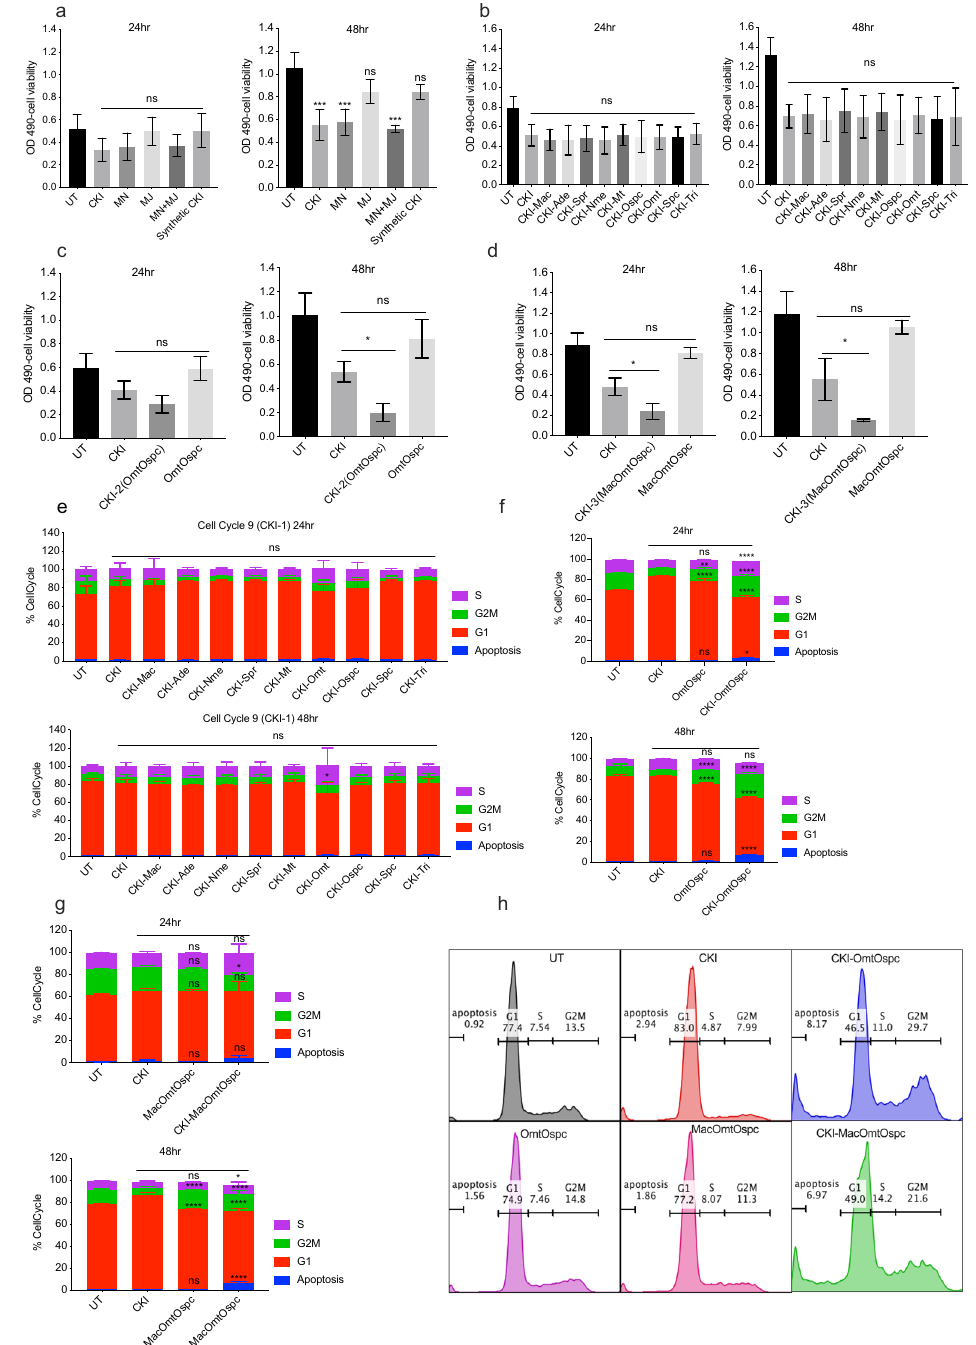
Figure 2. XTT cell viability assay and cell-cycle assay of subtractive fractions at 24- and 48-hour timepoint treatments in MDA-MB-231 cells treated with 2 mg/ml of CKI and 2 mg/ml equivalent concentrations of all other treating agents. ( a ) Suppression of cell viability from the following fractions: UT (untreated), MJ, MN, MJ + MN (combination of MJ and MN) and Syn_CKI (synthetic CKI generated using nine major compounds). ( b ) Effect of 9 (CKI-1) subtractive fractions compared to CKI. ( c ) Effect of CKI-OmtOspc subtractive fraction and OmtOspc compared to CKI. (d) Effect of CKI-MacOmtOspc subtractive fraction and MacOmtOspc, compared to CKI. Statistically significant results relative to CKI treatment shown as ( * )P < 0.05 or ns (not significant), all data were shown as mean ± SD. ( e ) Effect of 9 (CKI-1) subtractive fractions on cell-cycle in MDA-MB-231 cells as determined by PI staining assay. ( f ) Effect of CKI-OmtOspc subtractive fraction and OmtOspc on cell-cycle in MDA-MB-231 cells as determined by PI staining assay. ( g ) Effect of CKI-MacOmtOspc subtractive fraction and MOO on cell-cycle in MDA-MB-231 cells as determined by PI staining assay. ( h ) The representative histograms of cell-cycle analysis by the treatments as compared to UT. Statistically significant results shown as ( * )P < 0.05 or ( ** )P < 0.01 or ( *** )P < 0.001 or ( **** )P < 0.0001. All data were shown as mean ±